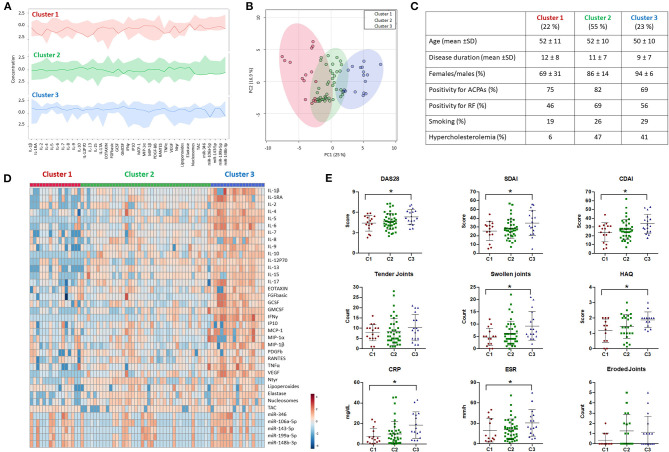
Cluster analysis of molecular features in rheumatoid arthritis patients. (A) Overview plot of the differential molecular profiles of Rheumatoid Arthritis (RA) patients (n = 74) using Self Organization Map (SOM) clustering analysis from MetaboAnalyst 4.0. The darker lines represent the median intensities of each cluster. (B) Principal component analysis (PCA) summarizing the differences in the molecular profile of each cluster. (C) Table of demographic and laboratory parameters of RA patients characterizing each cluster (Cluster 1 = 16; Cluster 2 = 41; Cluster 3 = 17). (D) Heatmap of the molecular profile of each cluster showing the normalized levels of all the biomolecules analyzed in RA patients. (E) Clinical features associated with each cluster including Disease Activity Score (DAS28), Simple Disease Activity index (SDAI), Clinical Disease Activity Index (CDAI), Tender and Swollen Joints, Health Assessment Questionnaire (HAQ), C-reactive protein (CRP), Erythrocyte Sedimentation Rate (ESR), and Bone Erosion. *p < 0.05.